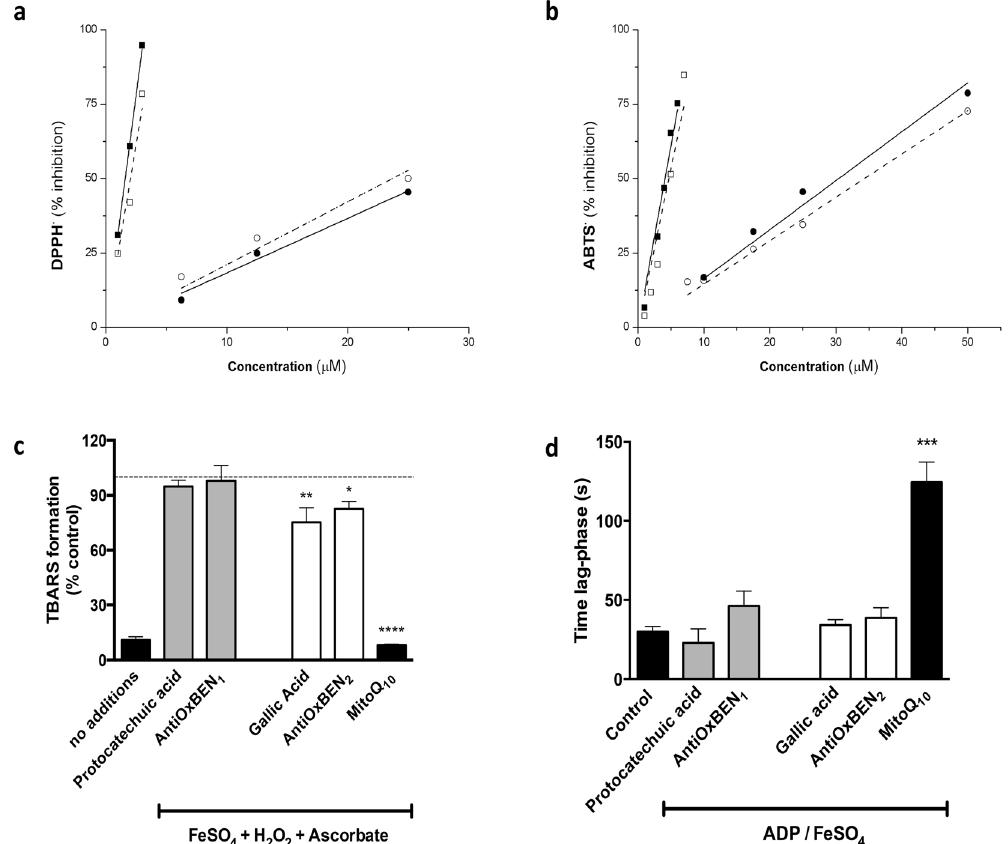
Figure 3. Antioxidant outline of mitochondria-targeted benzoic antioxidants. Radical scavenging activities of hydroxybenzoic acid derivatives on ( a ) DPPH and ( b ) ABTS radicals. •protocatechuic acid; ◾ gallic acid; οAntioOxBEN 1 ; and ◽ AntioOxBEN 2 . Effect of AntiOxBENs on mitochondrial lipid peroxidation: ( c ) TBARS levels and ( d ) oxidation-derived oxygen consumption under different oxidative conditions. Data are means ± SEM from three and six independent experiments and are expressed as % of control (control = 100%) for TBARS and time lag-phase (s) for oxidation-derived oxygen consumption assays, respectively. The comparisons between control preparation vs. AntiOxBENs (5 μ M) pre-incubations were performed by using one-way ANOVA. Significance was accepted with * P < 0.05, ** P < 0.01, *** P < 0.0005, **** P < 0.0001.